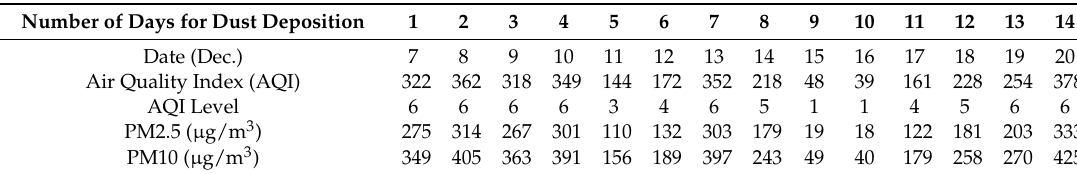
Figure 11. Efficiency reduction of PV panels with different tilt angle. Table 5. Dailyair quality of Baoding, China, 7–20 December 2015.